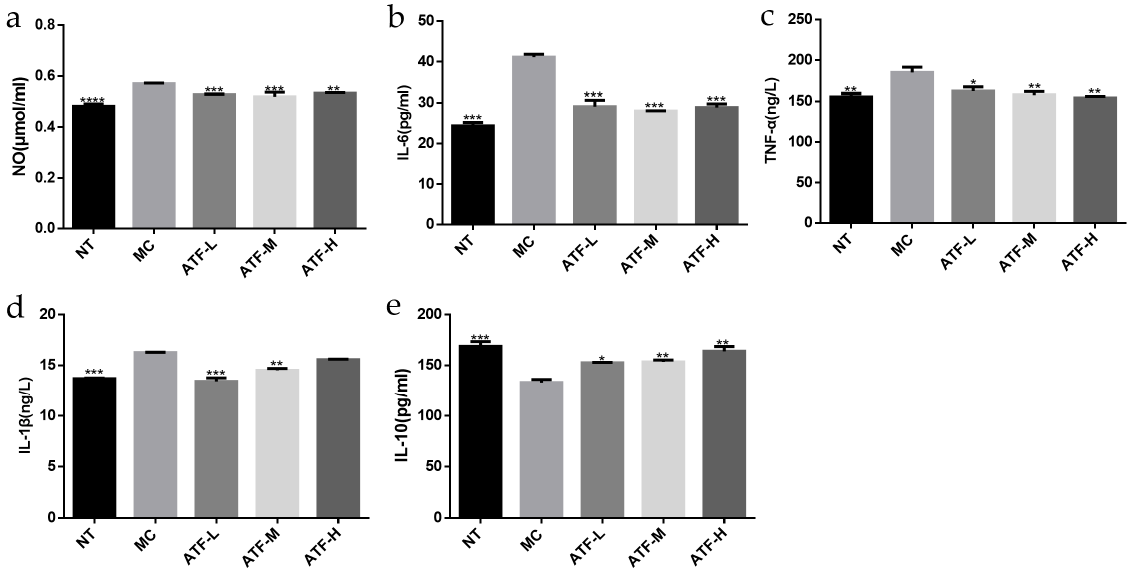
Figure 5. Determinations of NO content and inflammatory factor secretion in mouse peritoneal macrophages. ( a ) NO content. ( b ) IL-6 content. ( c ) TNF- α content. ( d ) IL-1 β content. ( e ) IL-10 content. NT: the no-treatment control group, MC: the model control group, ATF-L: ATF 10 µ g/mL, ATF-M: ATF 50 µ g/mL, ATF-H: ATF 100 µ g/mL. Data are expressed as mean ± SD. * p < 0.05, ** p < 0.01, *** p < 0.001 and **** p < 0.0001 compared with the MC group.